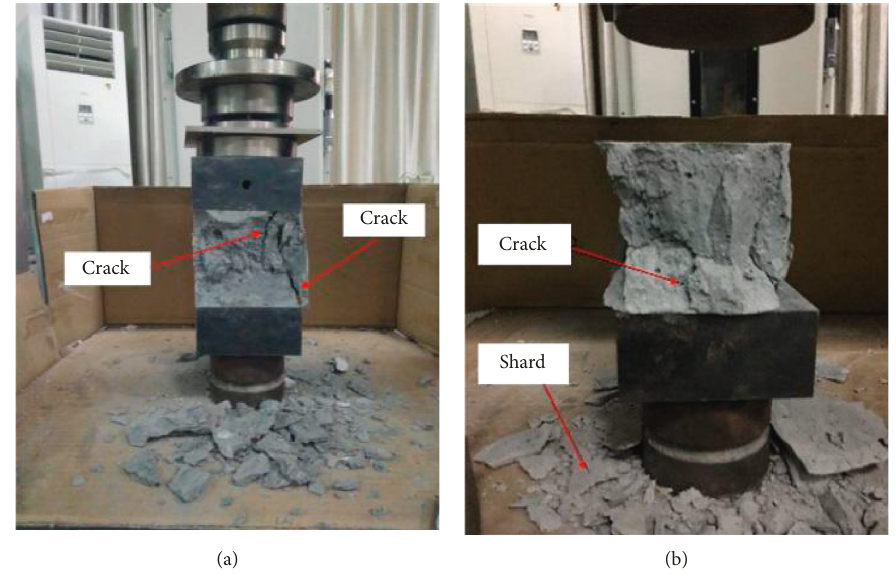
Figure 6: Typical condition of a test block after destruction: (a) cracking; (b) flaking and